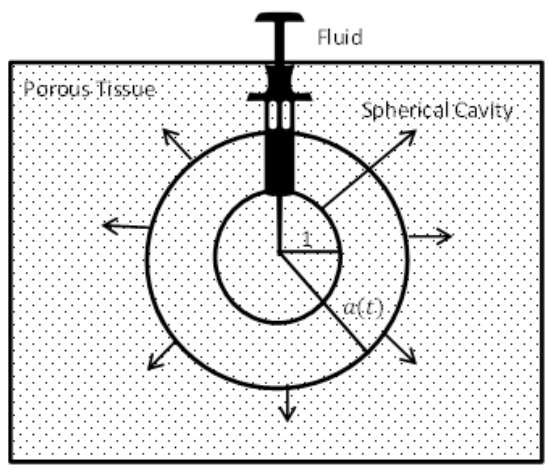
Figure 1. Radial flow after injection of fluid in an infinite porous media. The growth of cavity is occurring from radius 1 to a ( t )